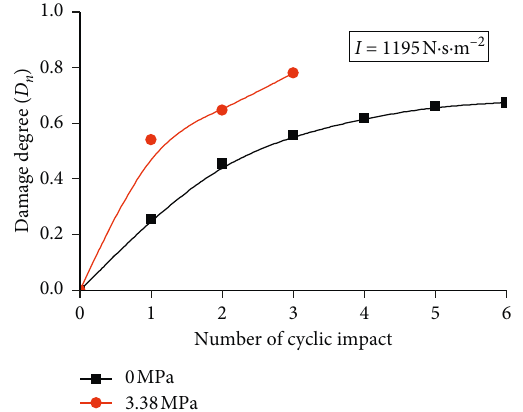
Figure 9: The relationship between damage degree and the number of cyclic impact under different axial